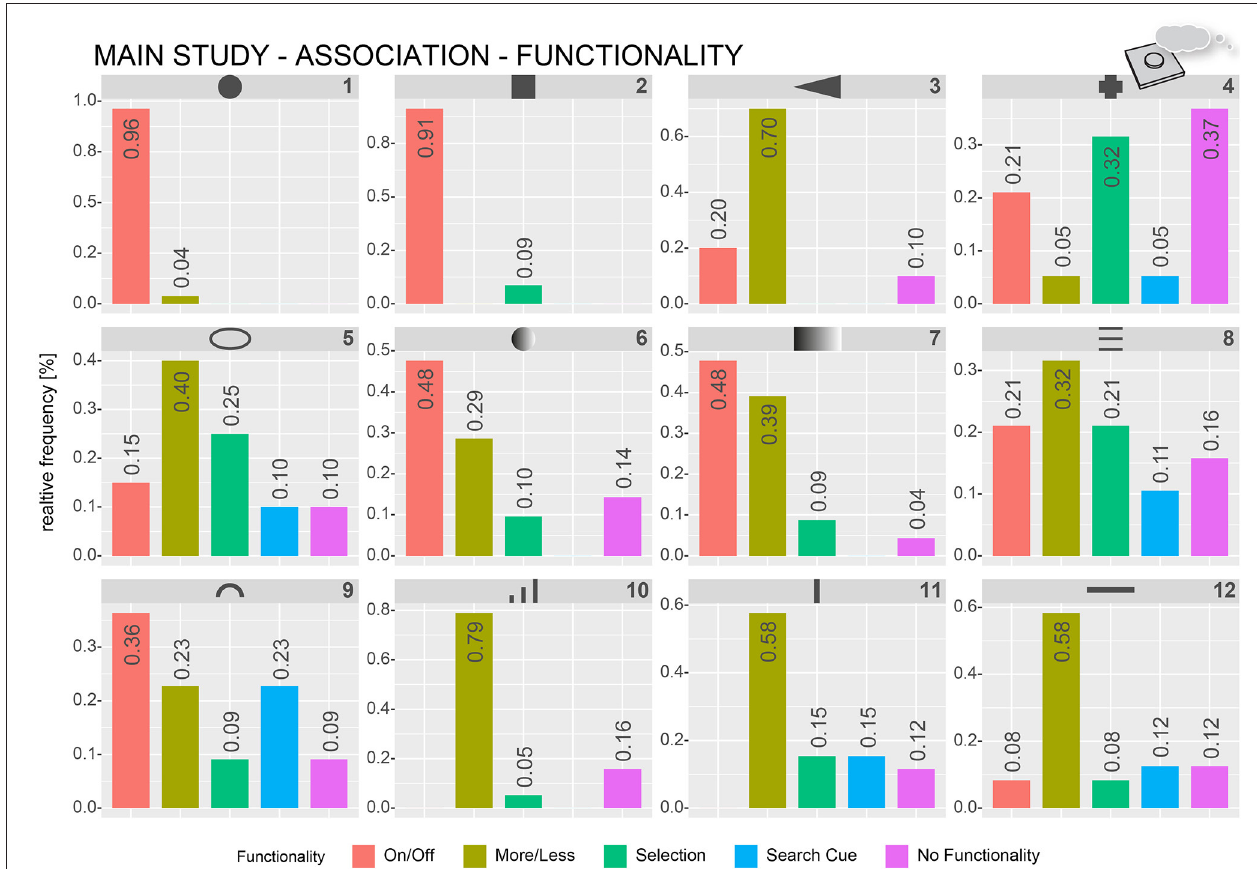
FIGURE 8 | Relative frequencies of how often specific functionality-based categories were assigned by the raters to describe verbal functionality associations of the participants. The numbers represent the relative frequency per category.